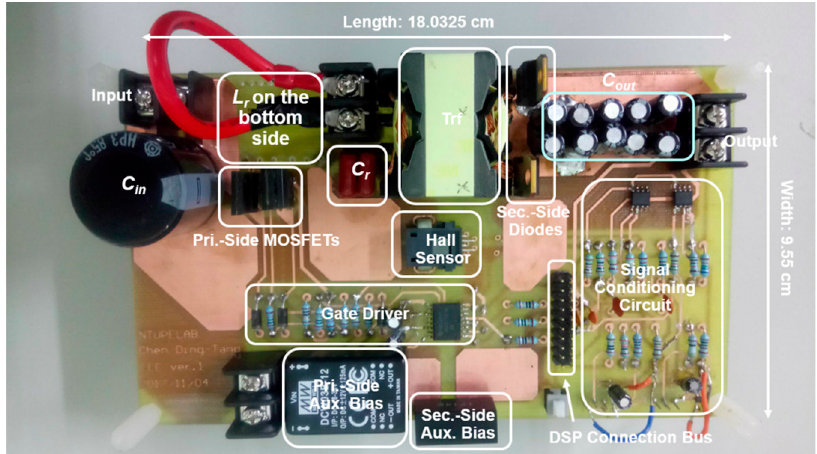
Table 1. Parameters of the LLC resonant converter.